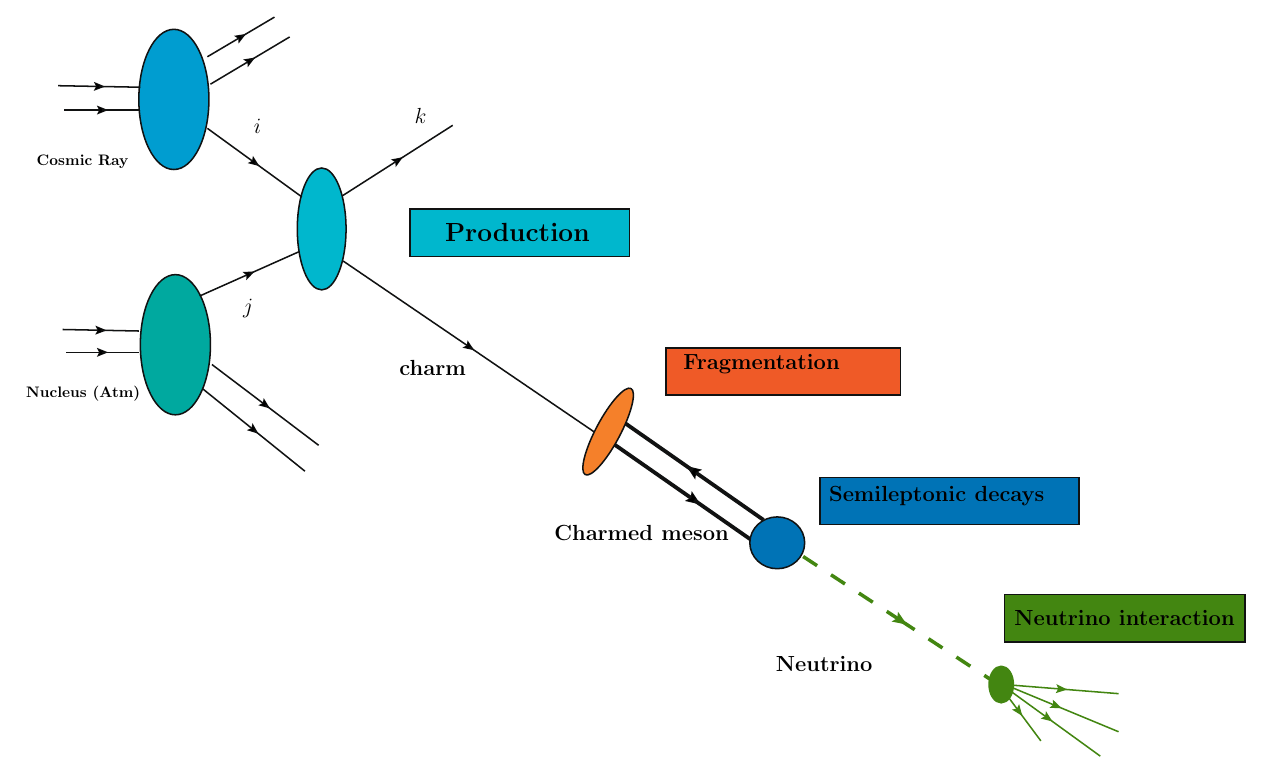
Fig. 1 Representation of the ingredients needed to estimate the prompt neutrino flux at the detector